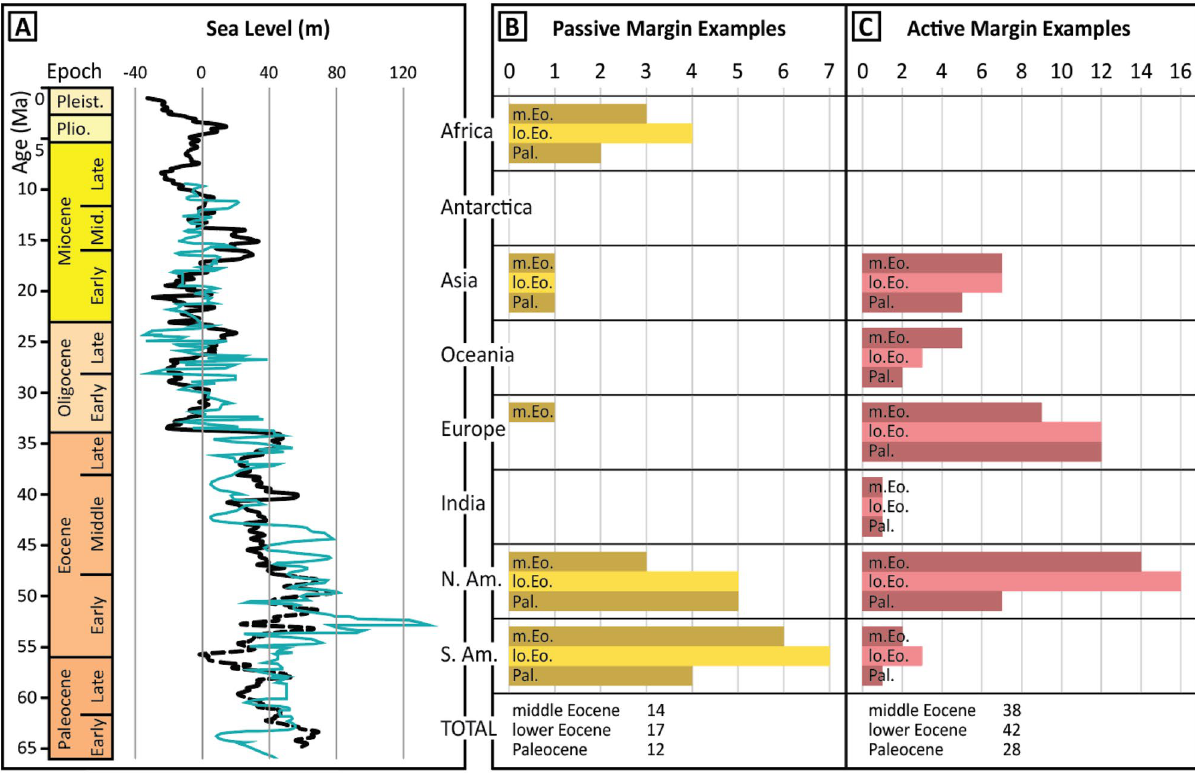
Figure 1. ( A ) Cenozoic sea-level curves of Miller et al. 22 in cyan and Miller et al. 23 in black. Bar charts with counts of ( B ) passive and ( C ) active margin sand-rich deposits for the Paleocene (Pal.), lower Eocene (lo. Eo.), and middle Eocene (m. Eo.) by continental margin. N. Am.—North America, S. Am.—South America. Location names and references are available in Supplementary